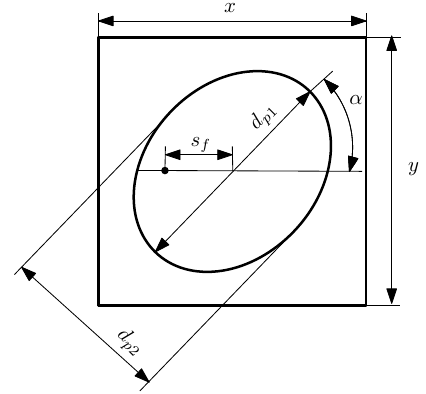
Figure 1. Shape of the antenna array